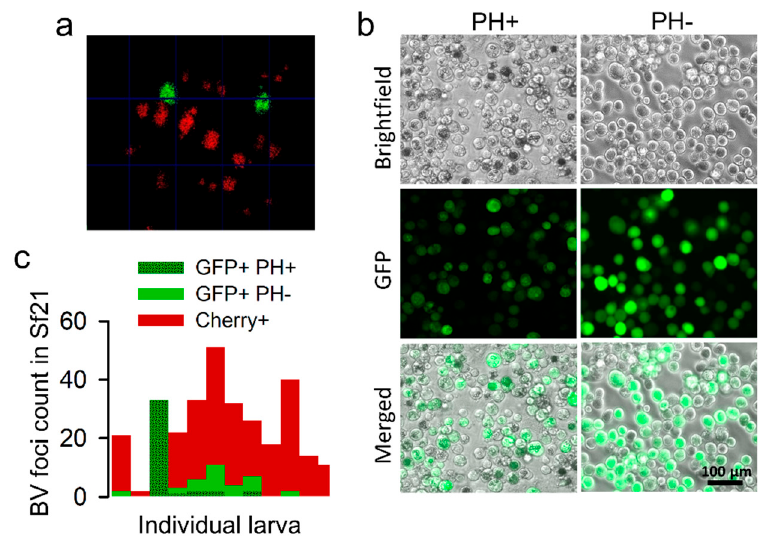
Figure 5. Detection of spontaneous recombinants by the foci assay. Serial dilutions of F2 BVs extracted from hemolymphs were used for inoculating Sf21 cultures, and individual foci were examined. ( a ). Representative image of GFP and Cherry foci at 96 hpi. ( b ). GFP-positive foci were further examined at 144 hpi by phase contrast and fluorescence microscopy to test for the absence (PH-) or presence (PH+) of OBs. ( c ). Foci count.